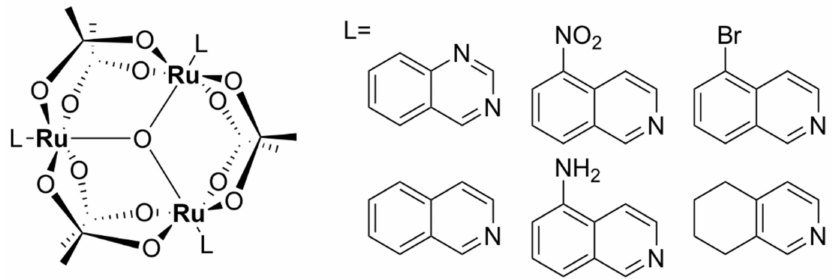
Figure 26. Chemical structures of symmetric trinuclear ruthenium complexes bearing azanaphthalene ligands with the general formula [Ru 3 O(CH 3 COO) 6 (L) 3 ]PF 6 . A range of Ru (II)–cyclopentadienyl thiosemicarbazone complexes displayed sub- or micromolar IC 50 values against T. cruzi and T. brucei . Notably, [RuCp(PPh 3 )L] (Figure 27),